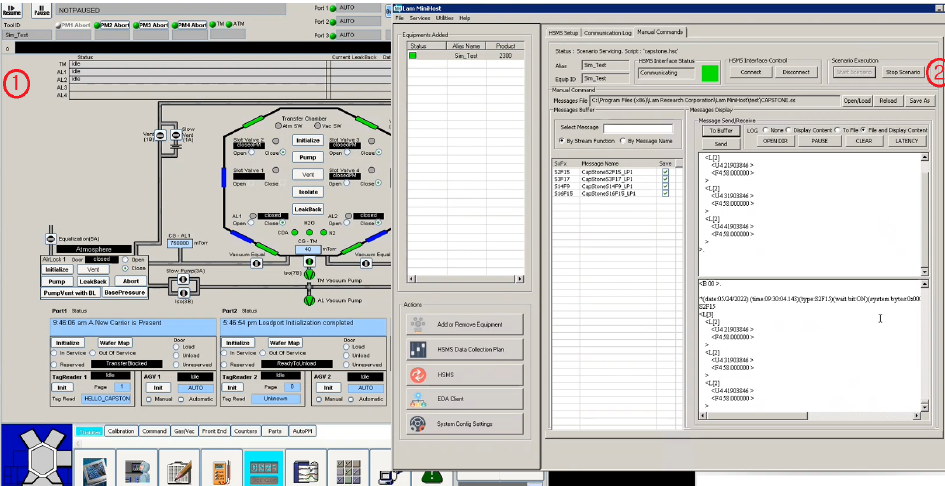
Figure 8. Etch cluster tool simulation connected to semiconductor fab host.